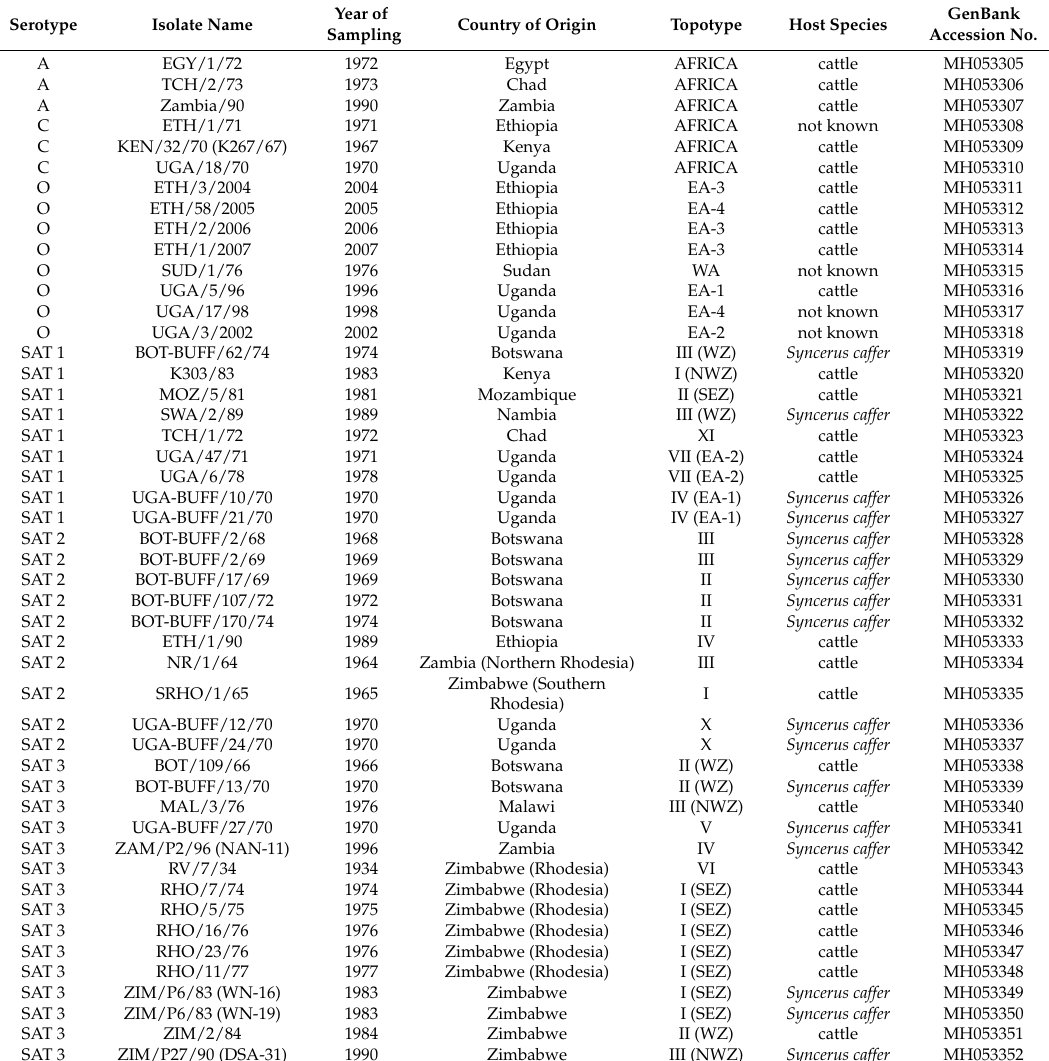
Table 1. Summary of foot-and-mouth disease virus (FMDV) isolates used in this study. SAT: Southern African